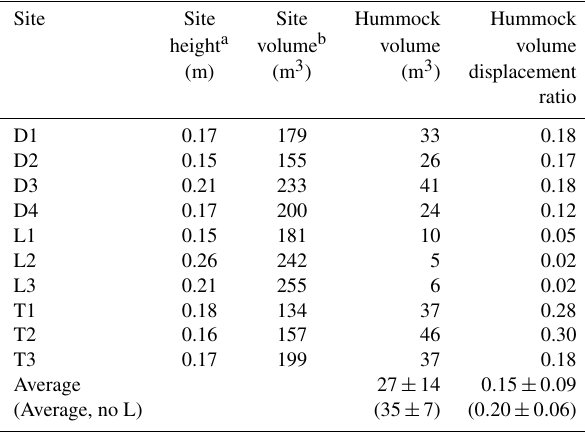
Table 4. Hummock volume displacement ratios for all